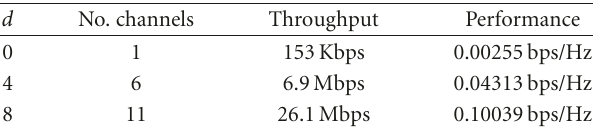
Table 2: Spectrum e ffi ciency of each